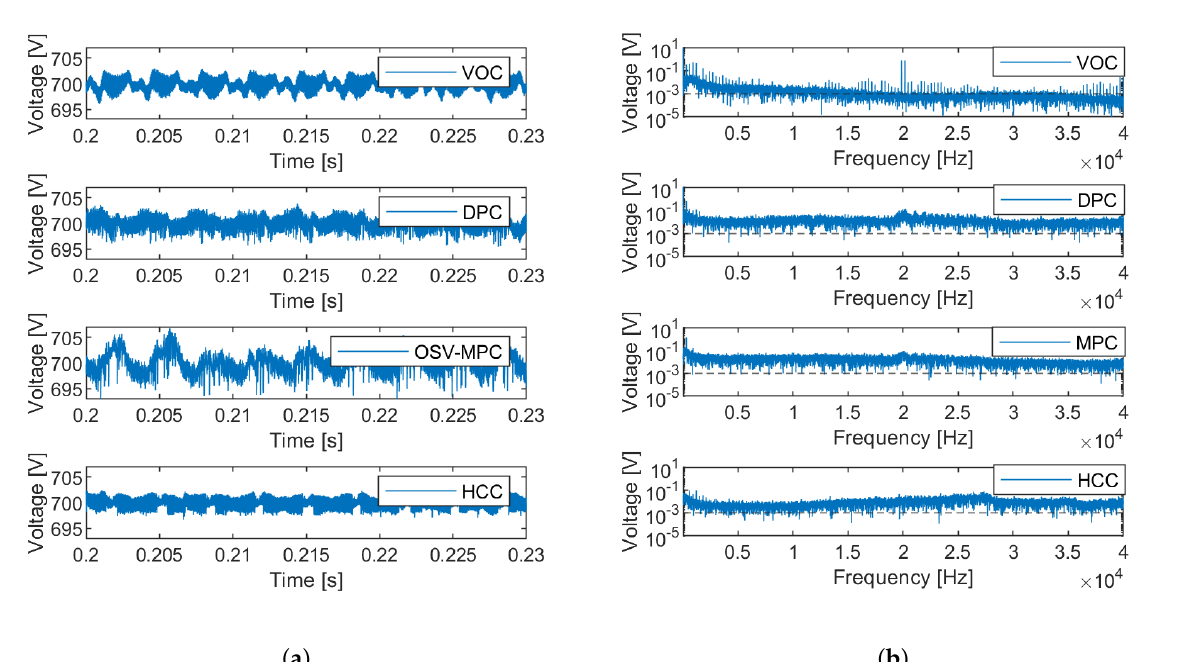
Figure 31. DC link voltage ripple for different control systems. ( a ) DC link voltage. ( b ) Harmonic content of DC link voltage.